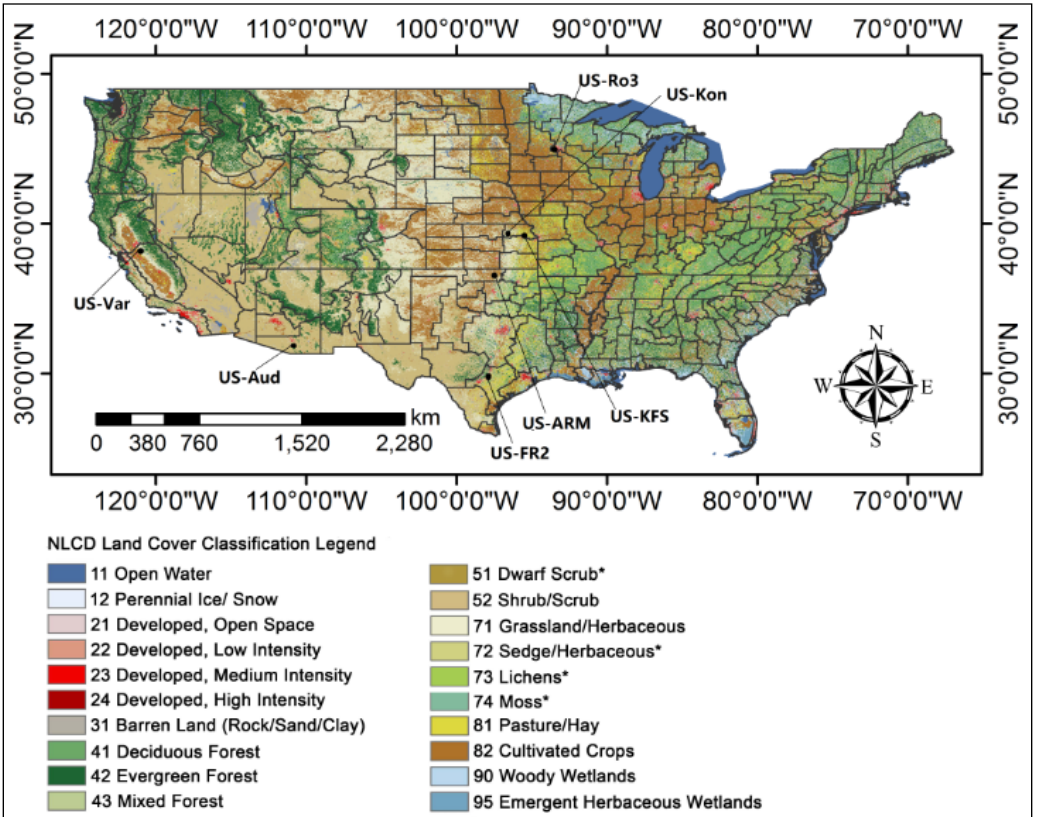
Figure 1. Location of the study area. The study area was divided into different climate divisions and the US-ARM, US-Aud, US-KFS, US-FR2, US-Kon, US-Ro3 and US-Var are names of the flux tower sites. The black circles are their geographic positions.